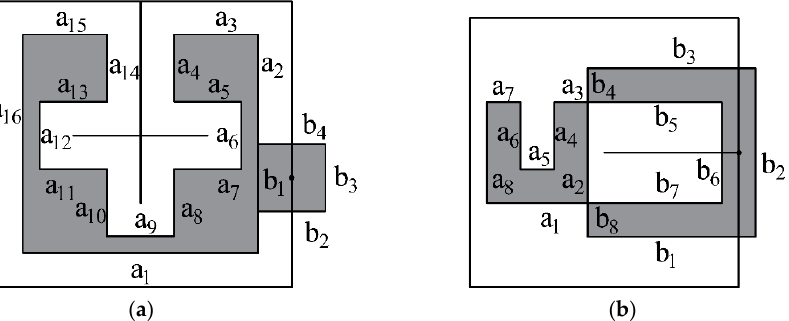
Figure 8. Examples of two polygons involving fitting passageways. ( a ) An example from literature; ( b ) An example from “Jakobs1” benchmark instance